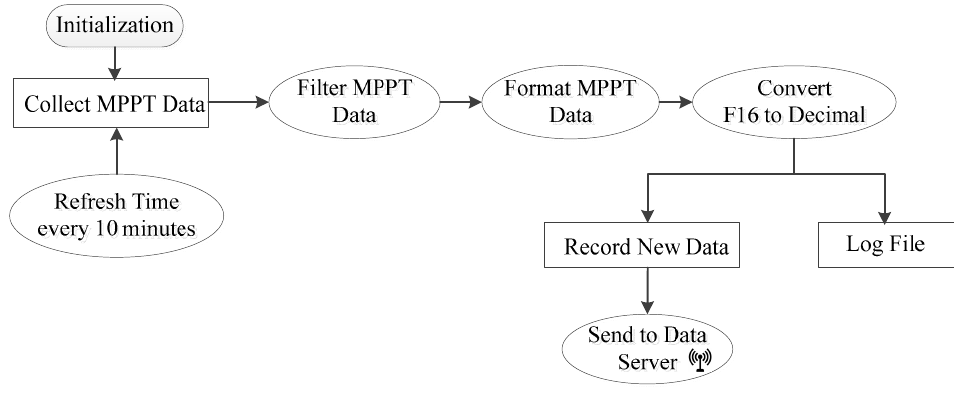
Figure 6. Flowchart for Data Monitoring.